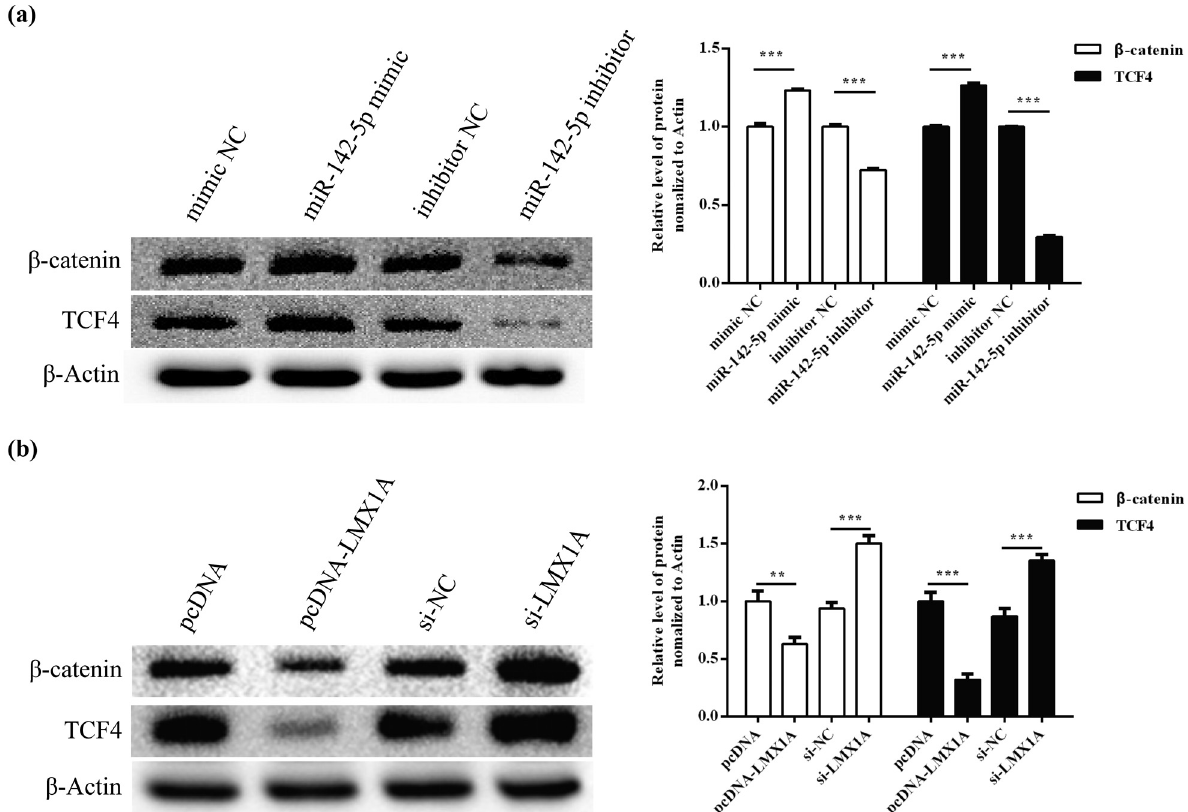
Figure 7: The e ff ect of miR - 142 - 5p and LMX1A on Wnt/ β - catenin pathway was assessed by Western blot. ( a ) Protein expression levels of TCF4 and β - catenin in HeLa cells after transfection with miR - 142 - 5p mimic and miR - 142 - 5p inhibitor. ( b ) Protein expression levels of TCF4 and β - catenin in HeLa cells after transfection with pcDNA - LMX1A and si - LMX1A. All experiments were performed in triplicate. ** P < 0.01. *** P <